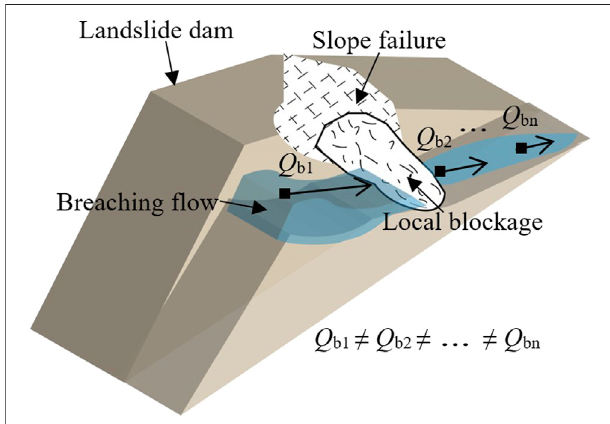
FIGURE 1 | The sketch of the variation of dam breaching discharge along the longitudinal direction during side slope failures.